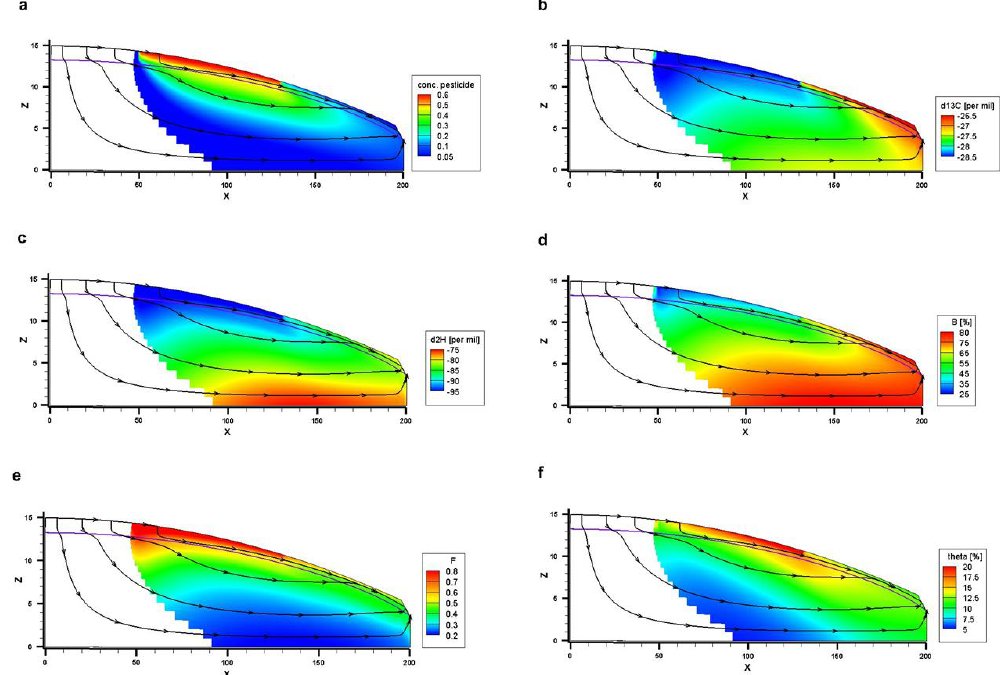
Fig. 3. Steady-state results for the pesticide concentration (a) ; δ 13 C-values (‰) of the pesticide (b) ; δ 2 H-values (‰) of the pesticide (c) ; extent of degradation (%, d ); relative contribution of the aerobic reaction to overall pesticide degradation (e) ; and underestimation (%) of the true extent of degradation when the Rayleigh equation is used (f) . Areas with a concentration reduction of more than three orders of magnitude relative to the source are blanked because CSIA would not be possible due to detection limits. The black arrows indicate streamlines of the steady-state flow field. The purple line shows the position of the water table. Vertical exaggeration is five